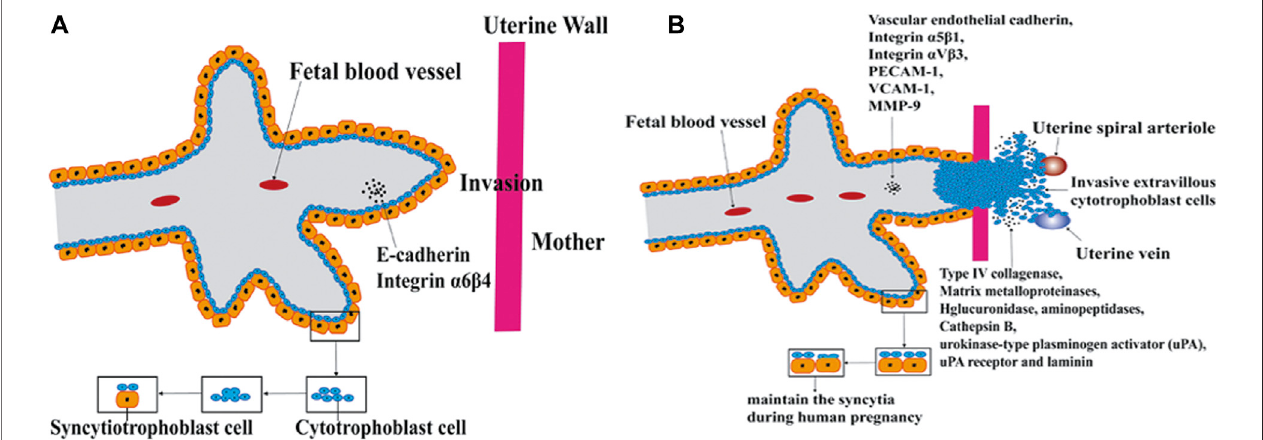
FIGURE 2 | Cell fusion in placenta formation. The formation of the placenta is accompanied by cell fusion and is divided into two stages according to the different roles in the fusion process. In the fi rst phase, cytotrophoblast cells fuse to form polynuclear syncytiotrophoblast cells. In the second phase, cytotrophoblasts and syncytiotrophoblastsfusefortissuerenewal. (A) Cytotrophoblastcellsfusetoformpolynuclearsyncytiotrophoblastcells. (B) cytotrophoblastsandsyncytiotrophoblasts fuse for tissue